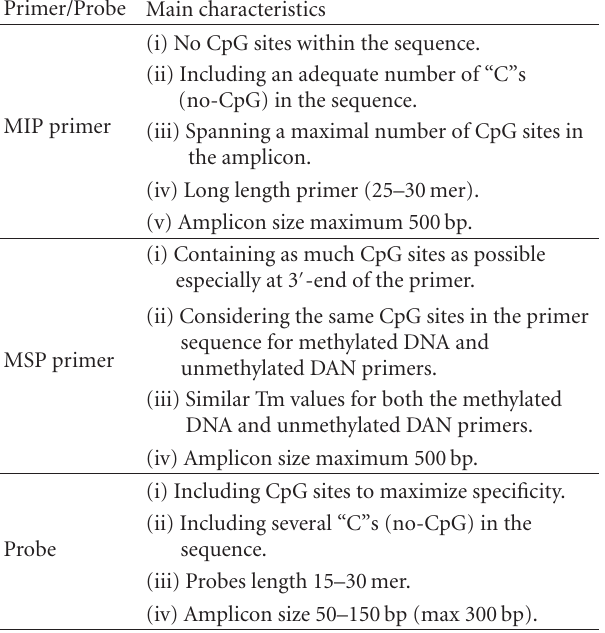
Table 1: The main characteristics for primer/probe designing in DNA methylation profiling techniques based on bisulfite conver-